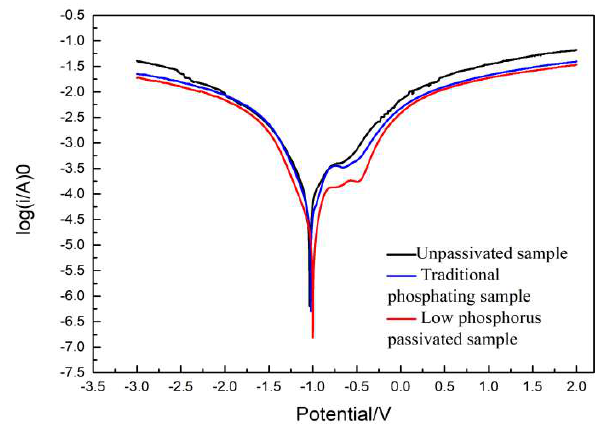
Figure 2. Electrochemical polarization curves of Q235 steel samples by different treatment methods in 3.5% NaCl solution. Table 4. Corrosion electrochemical parameters of unpassivated passivation, low phosphorus pas-